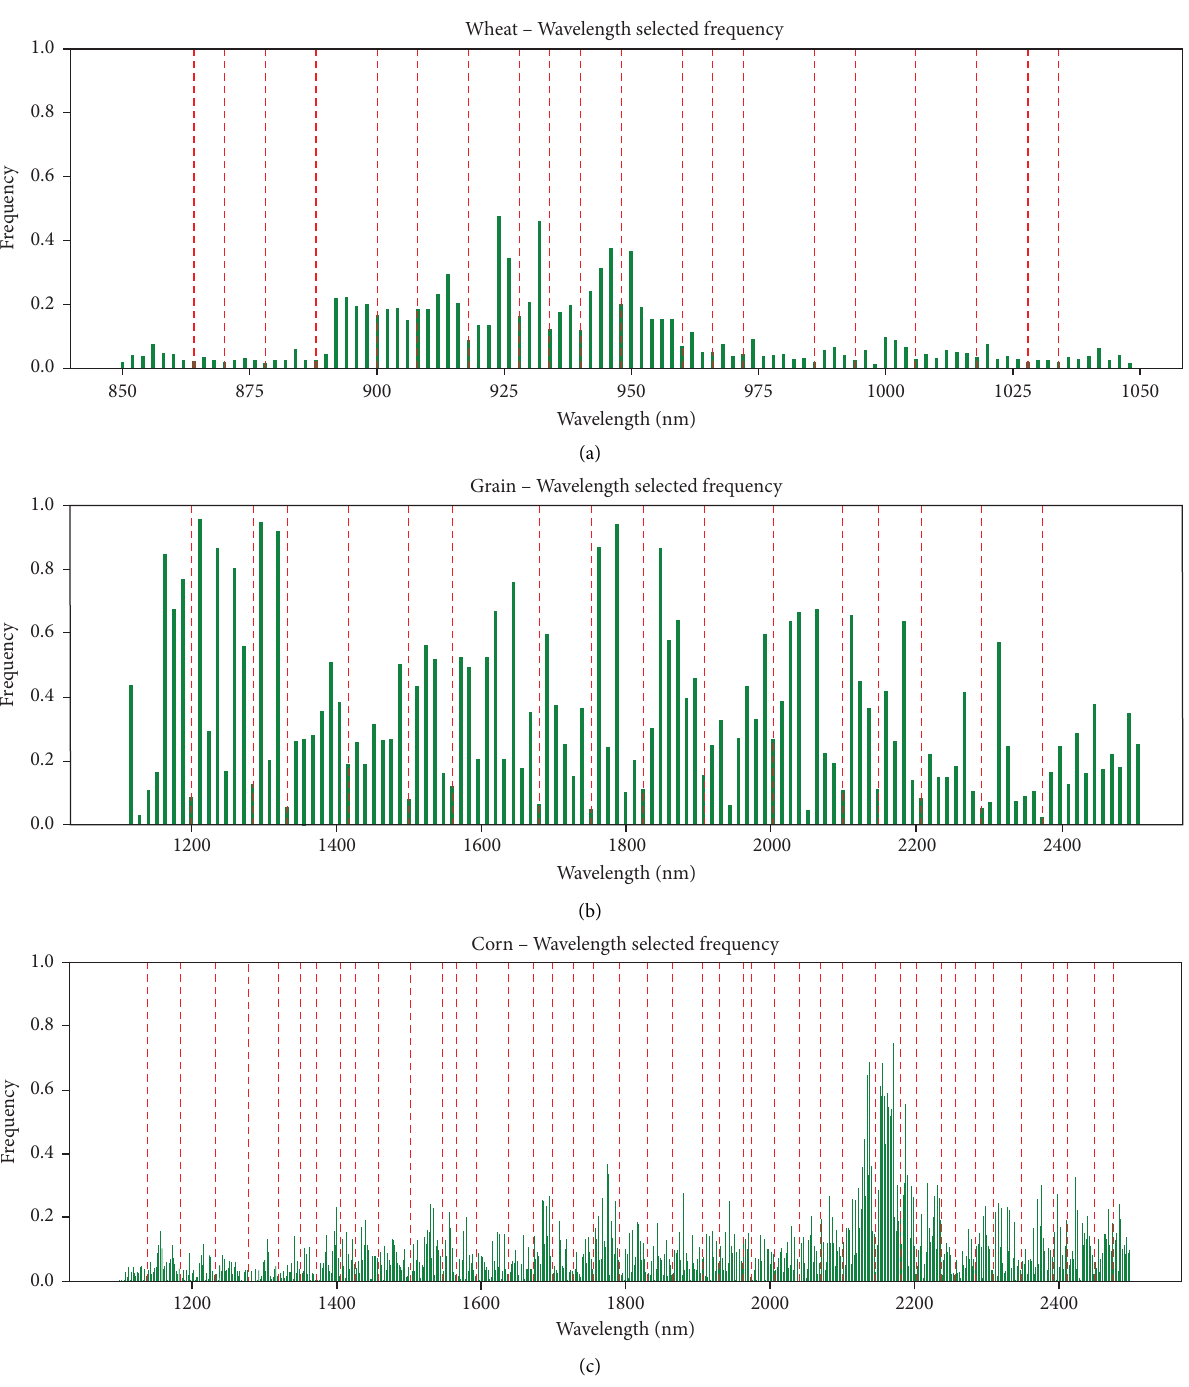
Figure 3: Frequency of selected wavelengths for individuals with MLR-ACO greater than the threshold for diferent datasets: (a) wheat protein dataset, (b) grain casein dataset, and (c) corn protein